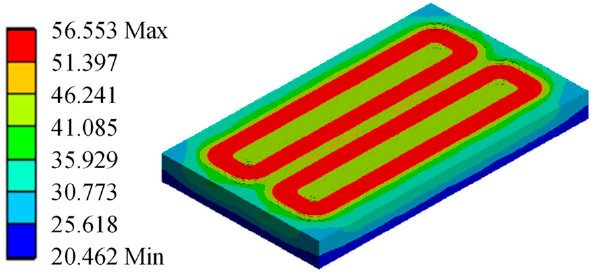
Figure 12. Forced water cooling simulation result at J = 13.33A/mm 2 .